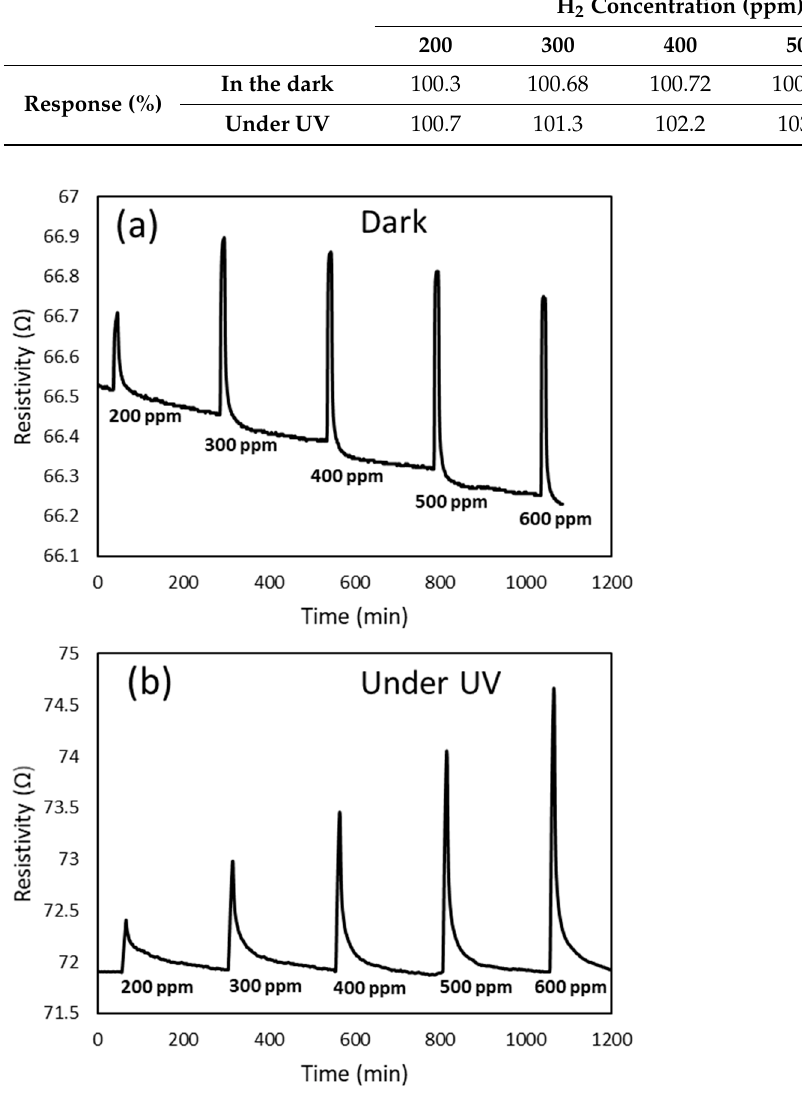
Figure 9. Dynamic response of Dy 2 O 3 -Pd-PDA/rGO sensor at 150 °C and 0 %RH as a function of hydrogen concentration, ( a ) without and ( b ) with UV illumination.